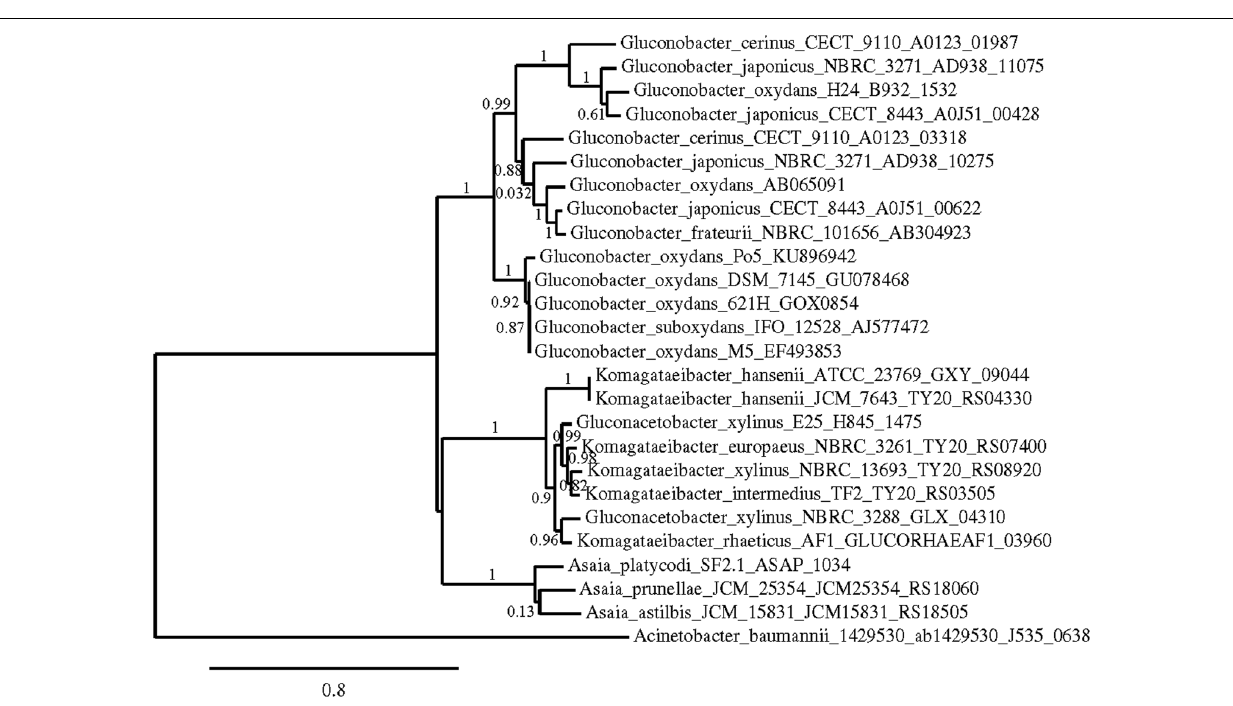
FIGURE 7 | Phylogenetic relationship of sld A gene in different species of acetic acid bacteria. The entries of different genotypes include the accession numbers of the GeneBank database sequence. The sld A sequence of Acinetobacter baumannii 1429530 was used as outgroup. The numbers indicate the branch support